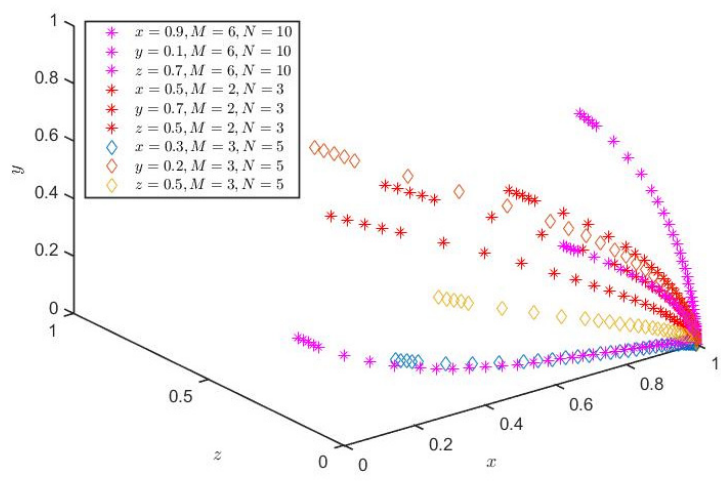
Figure 2. Effects of different default losses on evolutionary game strategies.